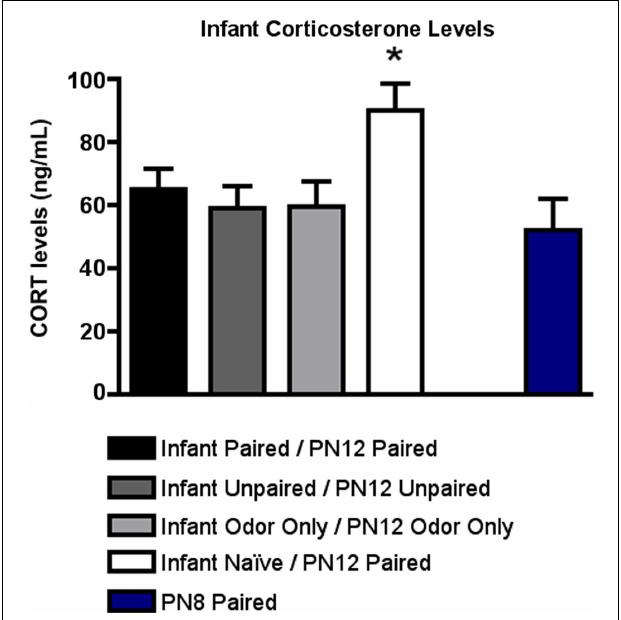
FIGURE 4 | RIA measurement from pups immediately following odor-shock conditioning indicates that CORT levels increased only in Infant Naïve/PN12 Paired pups receiving odor-shock conditioning for the fi rst time during the postsensitive period (PN12) ( n = 5–7/group). All other groups, including the Infant Odor Only/PN12 Odor Only group that did not receive shocks, show levels of CORT similar to PN8 Paired pups (still in the Stress Hyporesponsive Period; SHRP). Asterisk represents a signifi cant difference from each of the other groups ( p <